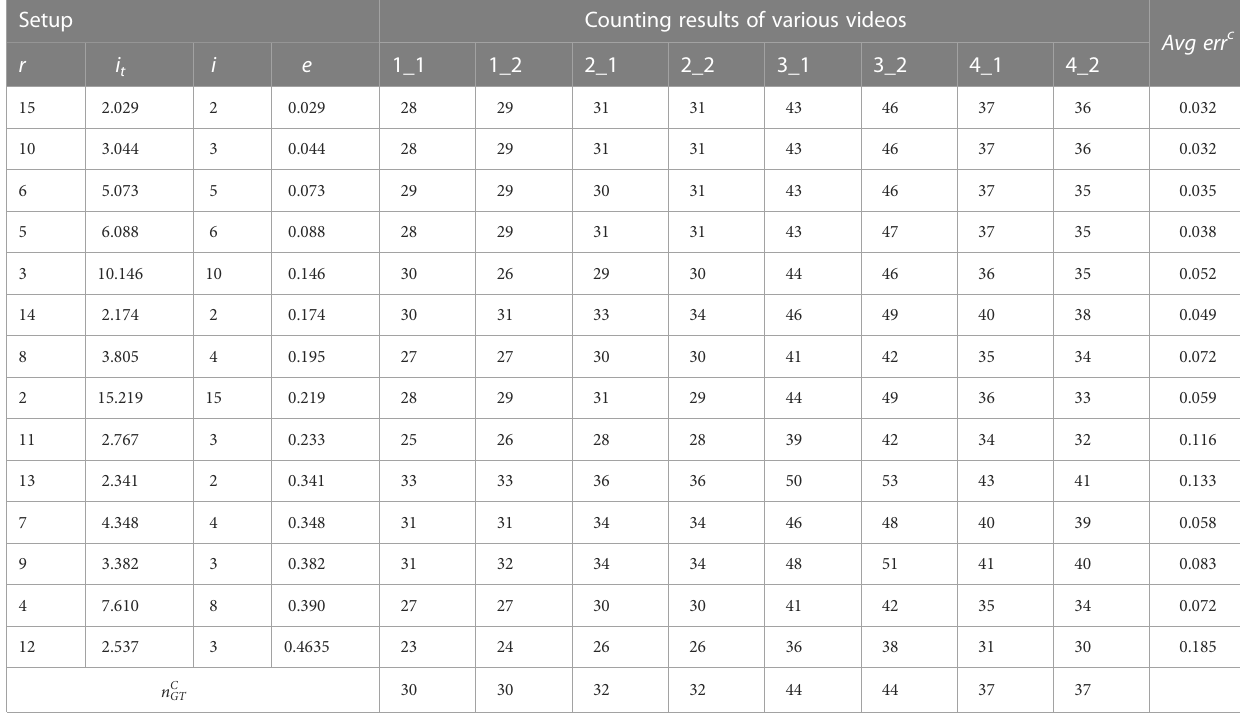
TABLE 4 The relative error rate of fruit counting under different algorithm setups.